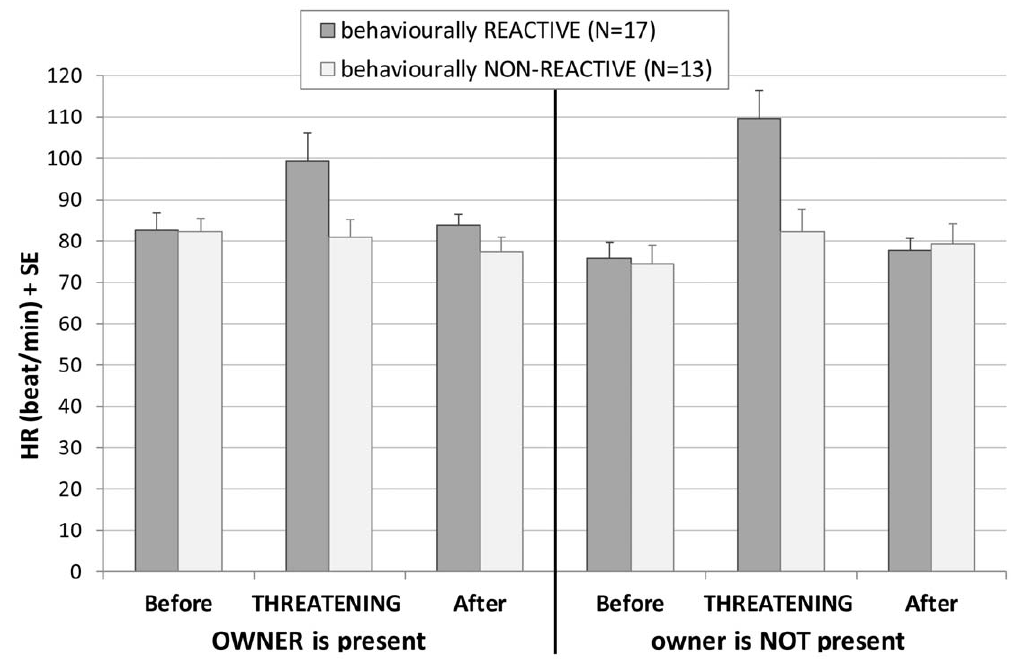
Figure 2. Effects of the threatening approach on the HR depending on the reactivity to the stranger. Changes in the mean heart rate (HR) of behaviourally reactive and non-reactive dogs in the episodes before, during and after the threatening encounter in the presence and absence of the owner. Dogs that growled or barked during the threatening encounter were categorised as behaviourally reactive. doi:10.1371/journal.pone.0058475.g002 PLOS ONE |